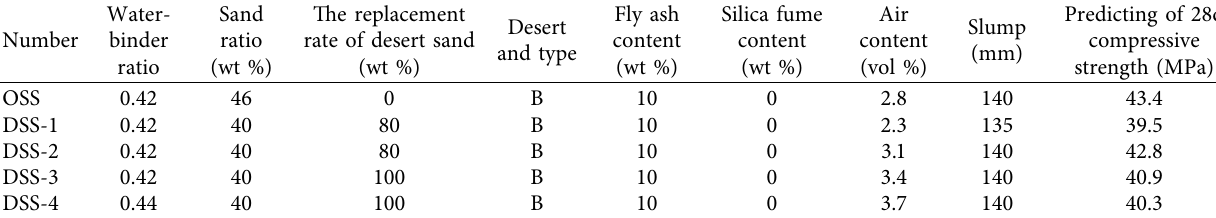
Table 3: Mix proportion of shotcrete for testing.